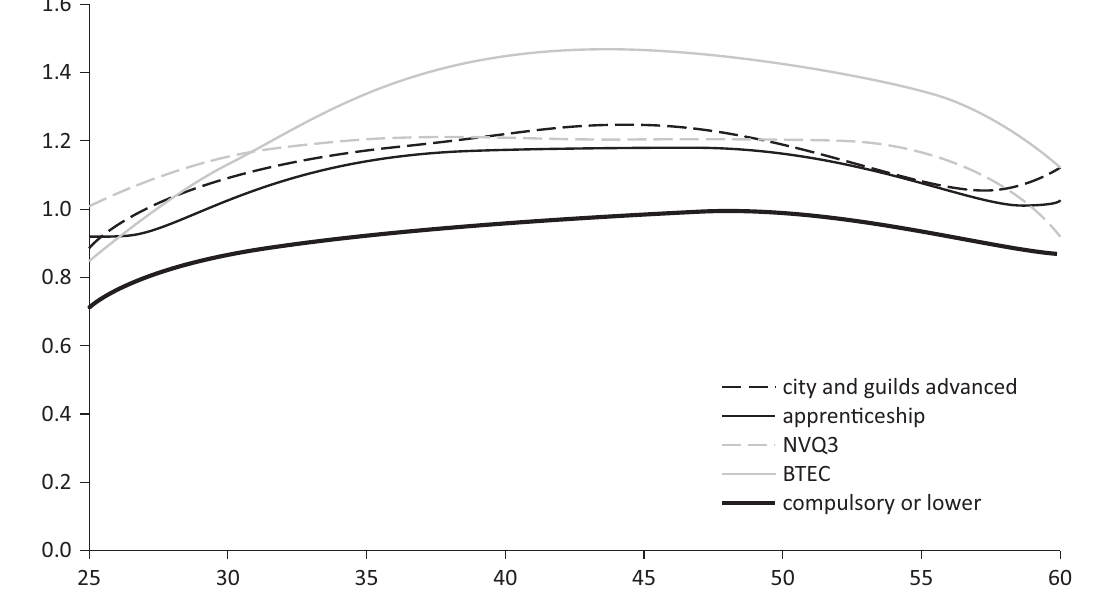
Figure A7. Median annual work income by type of upper-secondary vocational education. Men—United Kingdom. Source: UK Labour Force Survey 1993–2014. Note: 1 = Median annual income for UK (£21,025).